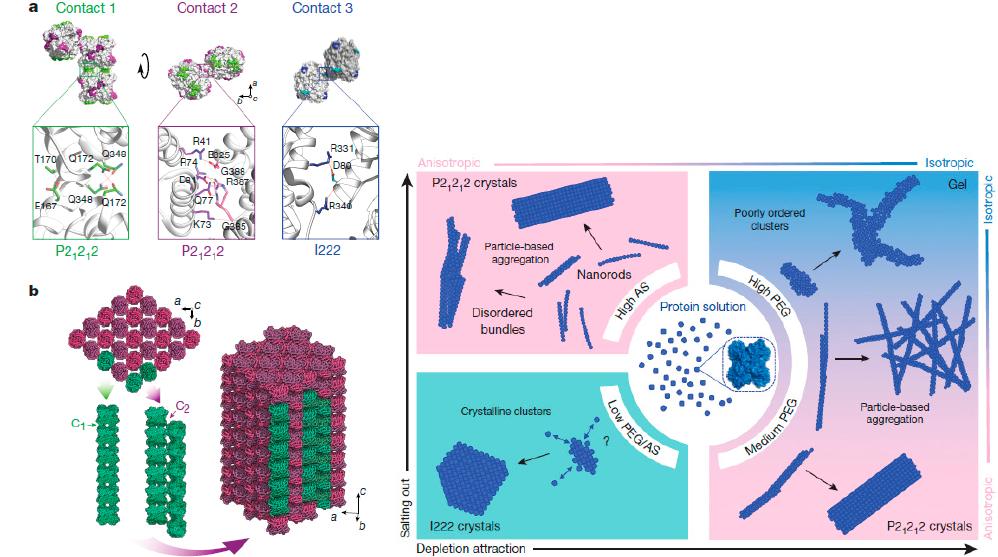
Figure 11. Effect of different contacts in the formation of specific glucose isomerase polymorphs [16]. Figure 11. E ff ect of di ff erent contacts in the formation of specific glucose isomerase polymorphs [16]. With permit of the copyright (Copyright Clearence Center License 4635640920216). With permit of the copyright (Copyright Clearence Center License